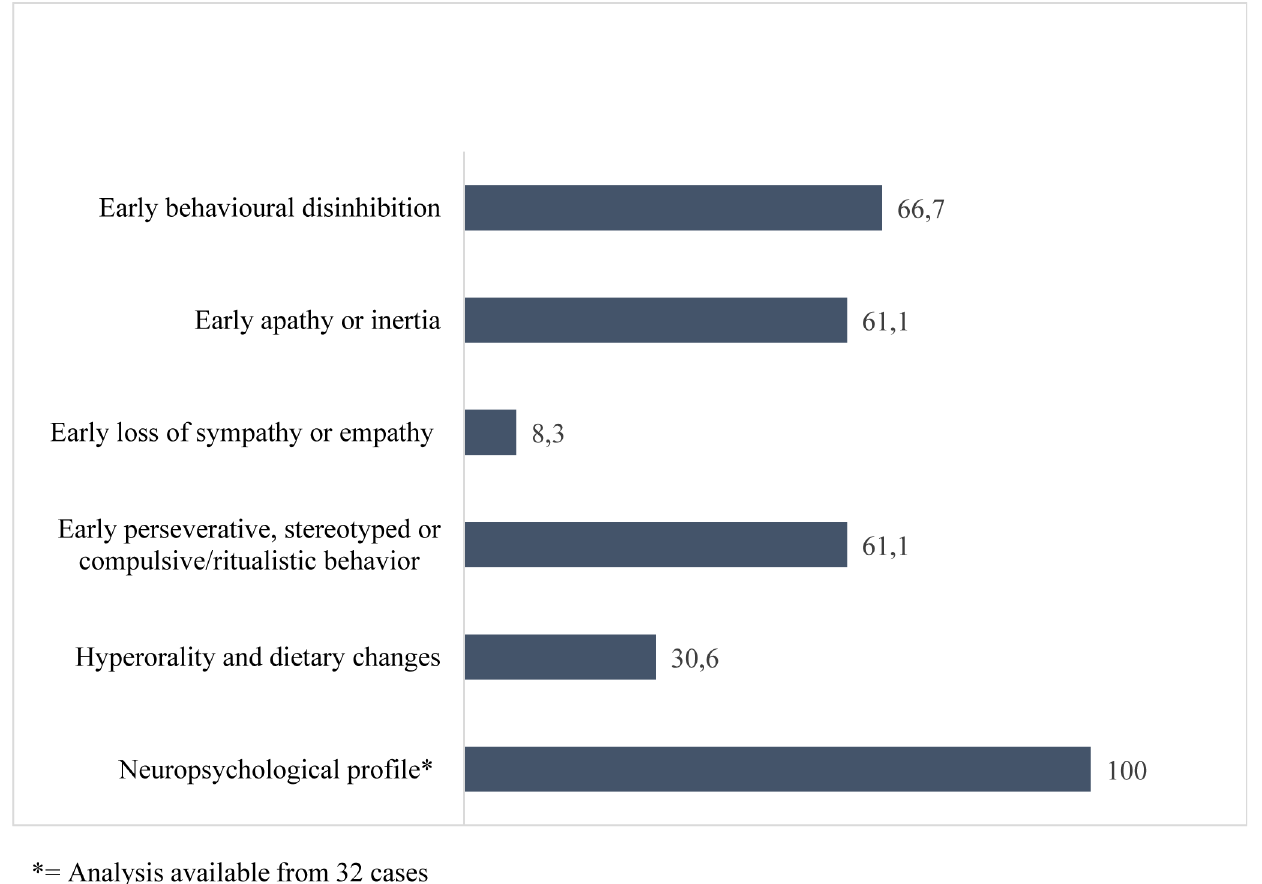
Fig 2. Frequency of behavioural and cognitive symptoms in patients with the C9ORF72 expansion (%). The numbers at the end of the bars represent percentage frequencies. Neuropsychological examination was done to 32 study subjects out of